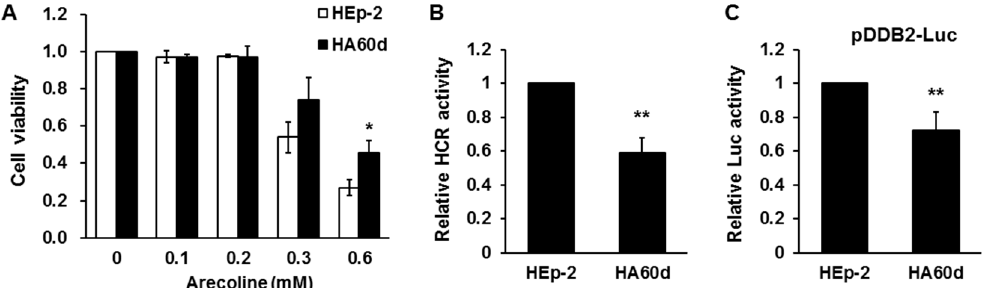
Figure 5. Long-term arecoline treatment leads to suppression of DDB2 promoter and nucleotide excision repair (NER) activity. The long-term arecoline-treated HA60d cells were obtained by repetitive treatment of arecoline (0.3 mM for 6–8 h / day) for 60 days. ( A ) MTT assays show the cell sensitivity to arecoline treatment for 48 h; ( B ) HCR assay showed an impaired NER activity in HA60d cells; ( C ) DDB2 promoter activity was decreased in HA60d cells. Data are shown as mean ± standard deviation ( n = 3–4). *, p < 0.05 versus HEp-2 cells; **, p < 0.01 versus HEp-2 cells.